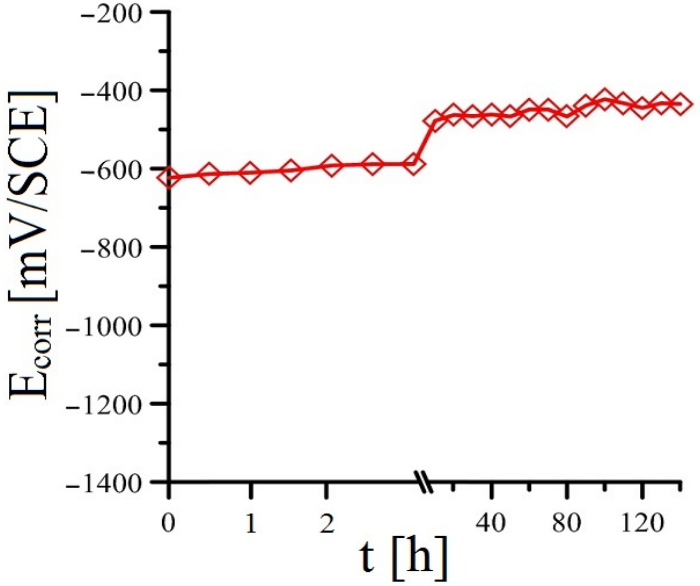
Figure 7. Evolution of open-circuit potential (E corr ) in samples of HDG steel in concrete with addition of MnO 4 − (Mn (2) )—(mean values).